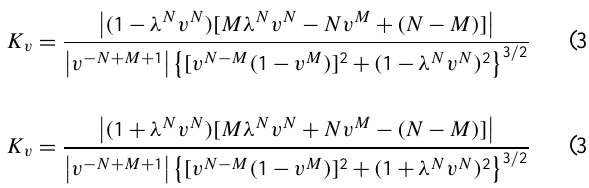
also in adverse